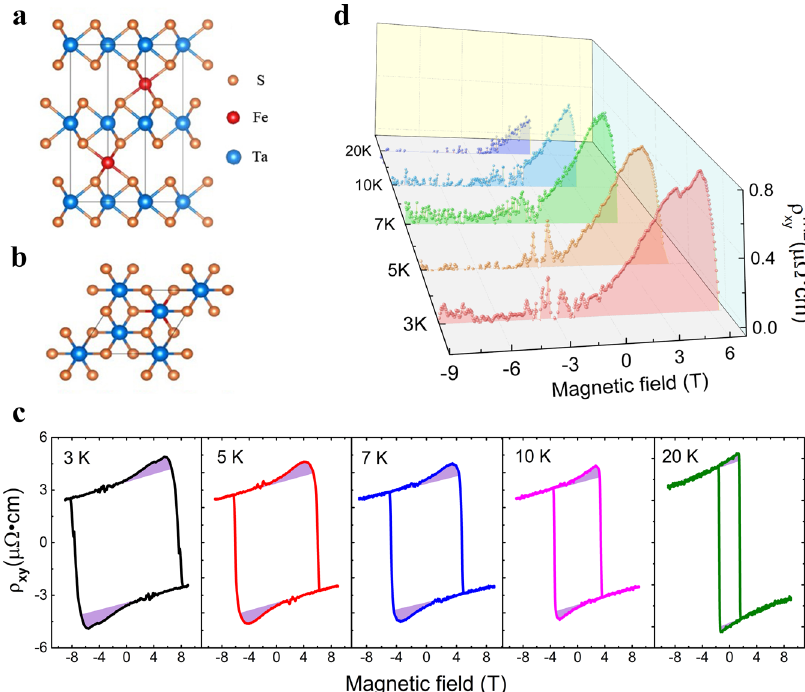
Fig. 1 Topological Hall effects observed in Fe-intercalated 2H-TaS 2 . a , b Crystal structures of Fe 1/3 TaS 2 of front view ( a ) and top view ( b ). c Temperature-dependent Hall resistivity ρ xy in Fe 0.28 TaS 2 nano fl akes. Topological Hall resistivity components ρ T xy are shadowed by the light purple colour. d Temperature-dependent Topological Hall resistivity components ρ T xy DMI. Figure 3b exhibits the gate-tuned topological Hall and